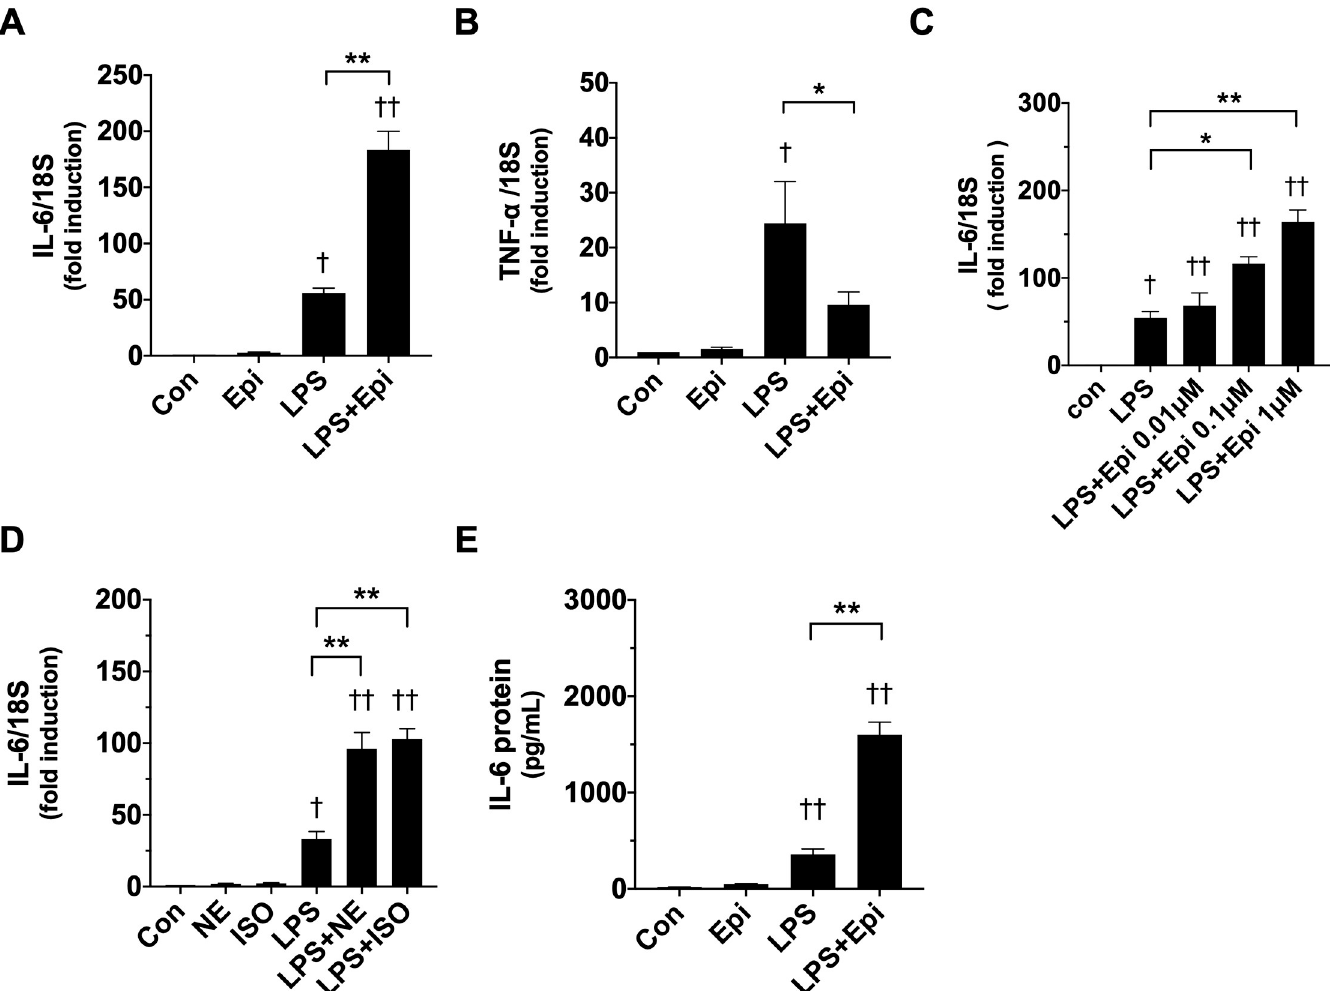
Fig 4. Catecholamines potentiated LPS-induced interleukin (IL)-6 production. C2C12 myotubes were exposed for 3 h to LPS (50 ng/ml) and/or Epi (1 μ M) (A, B, and E), Epi of the indicated concentration (C) and NE (1 μ M) or ISO (1 μ M) (D). The mRNA expression levels of IL-6 (A, C, and D) and TNF- α (B), were analyzed by qRT-PCR. Data are normalized to the 18S rRNA expression level and fold induction relative to the value of the control condition is presented as mean ± SEM (n = 3). IL-6 concentration in the conditioned media was analyzed by the enzyme-linked immunosorbent assay (ELISA) assay (E). Data are presented as mean ± SEM (n = 4–6). (†P < 0.05 and ††P < 0.005 compared with control, � P < 0.05 and �� P < 0.005 for comparisons between the indicated